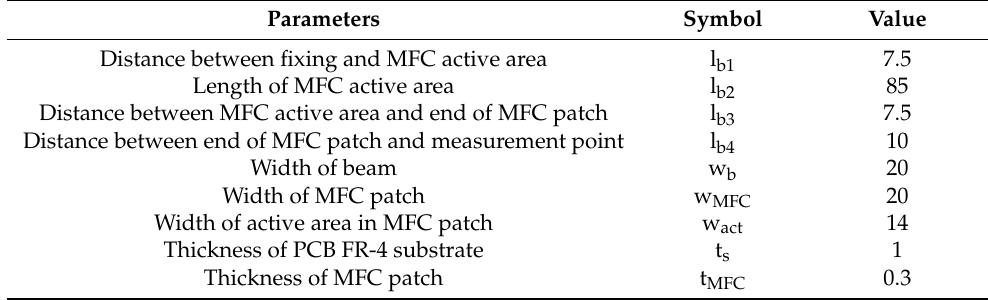
Table 2. Dimensions of the cantilever beam (values in mm). Parameters Symbol Value Distance between fixing and MFC active area l b1 7.5 Length of MFC active area l b2 85 Distance between MFC active area and end of MFC patch l b3 7.5 Distance between end of MFC patch and measurement point l b4 10 Width of beam w b 20 Width of MFC patch w MFC 20 Width of active area in MFC patch w act 14 Thickness of PCB FR-4 substrate t s 1 Thickness of MFC patch t MFC